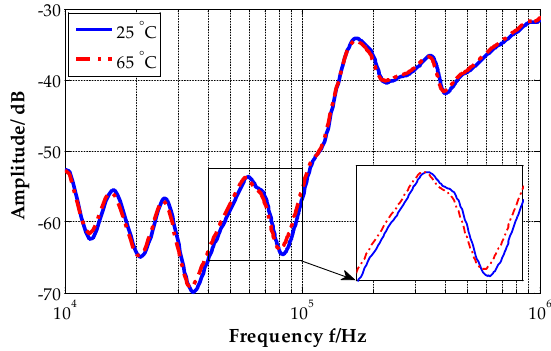
Figure 13. The middle phase frequency response of a three-phase oil transformer for two different temperatures. The traces correspond to the CI connection.